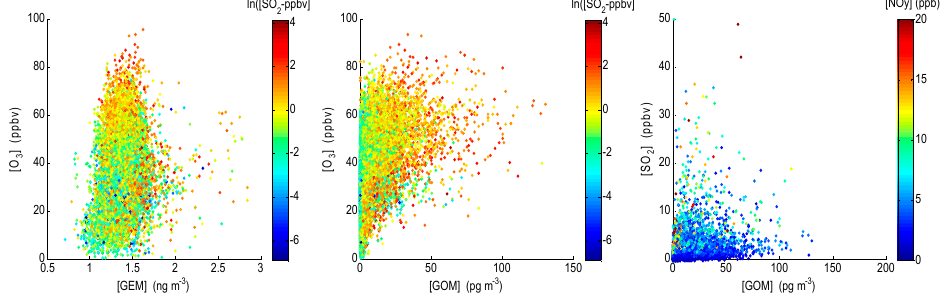
Figure 9. Scatter plot of ozone versus GEM ( left ) and GOM ( middle ) colored with ln([SO 2 ppb]), as well as SO 2 versus GOM colored with NO Y concentrations ( right ) for the daytime data (with solar radiation greater than 20 W m − 2 ) collected at the Grand Bay site from 2007 to 2018.